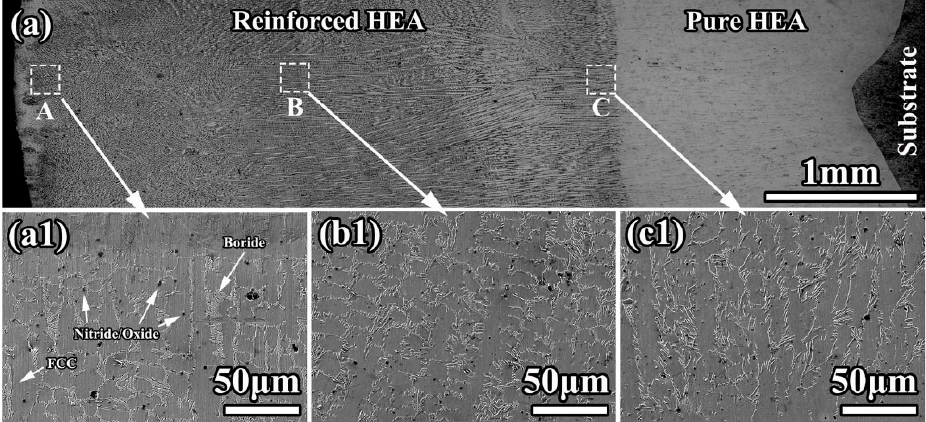
Figure 14. ( a ) Light micrograph for the cross-section of composite coating; ( a1 , b1 , c1 ) are the SEM micrographs showing the morphology in the A, B, and C areas in ( a ). Reprinted with permission from ref. [106]. Copyright 2022 Elsevier.